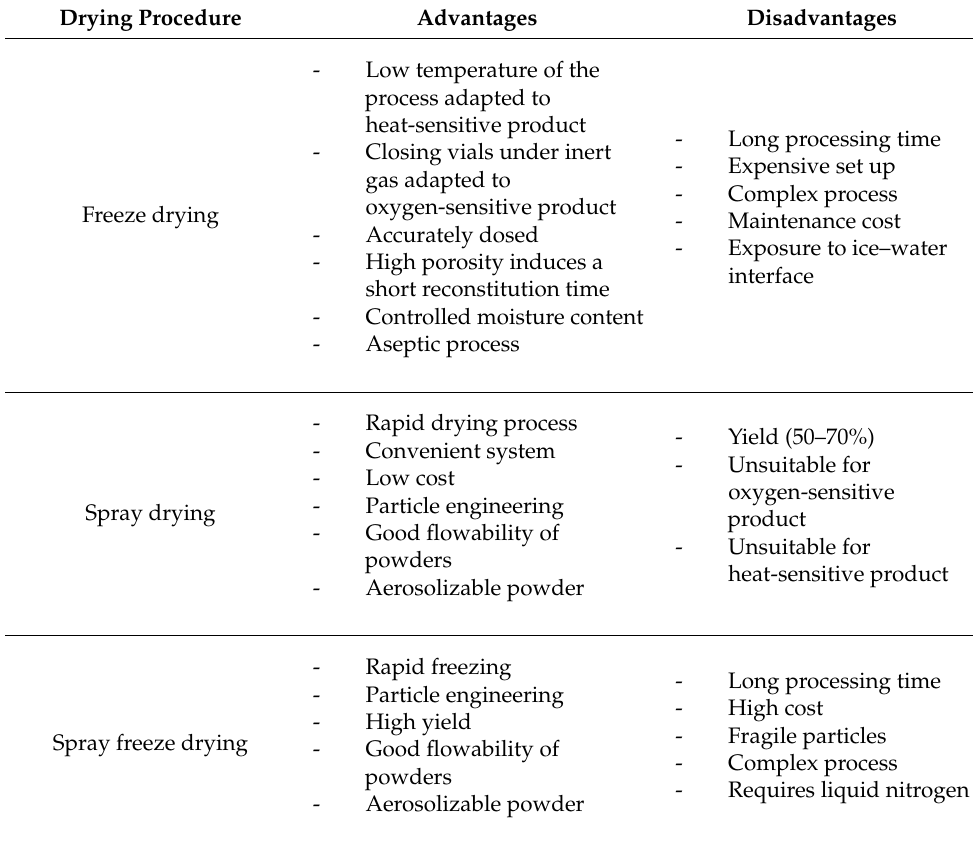
Table 2. Advantages and limitations of the following processes: freeze drying, spray drying and spray freeze